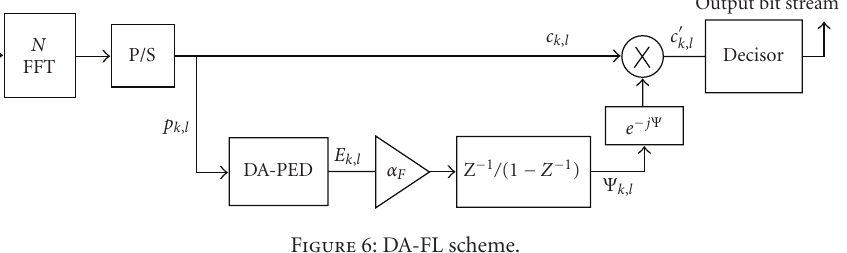
Figure 6: DA-FL scheme.